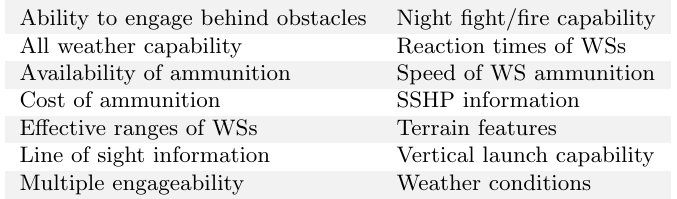
Table 1: A list of factors which may influence the choice of assignment during the WA process, obtained from responses to the WA survey in the appendix at the end of this